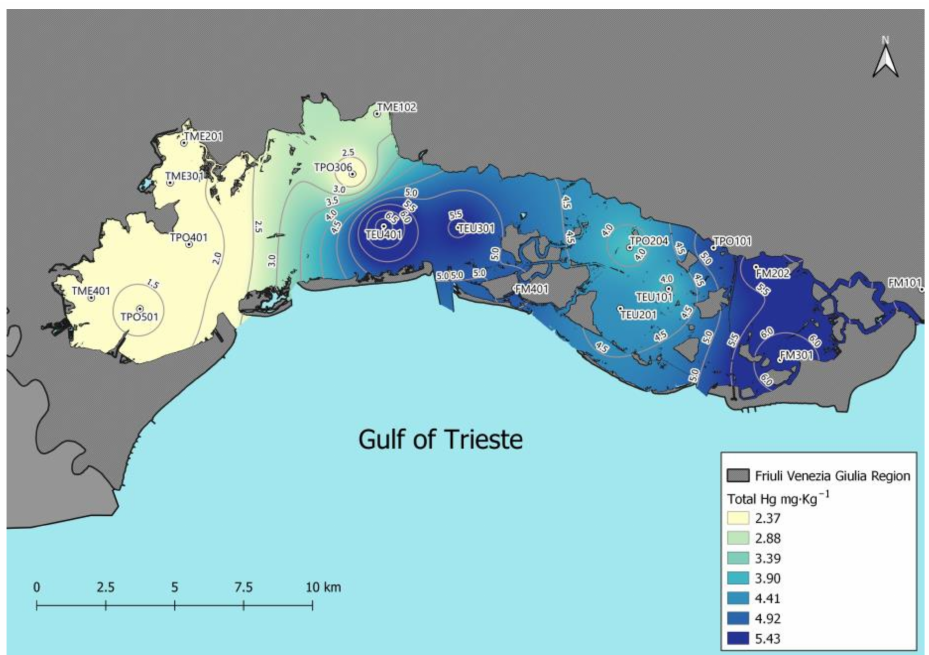
Figure 2. Spatial distribution of total Hg in surface sediments of the MGL was obtained by IDW (Inverse Distance Weighted) interpolation.